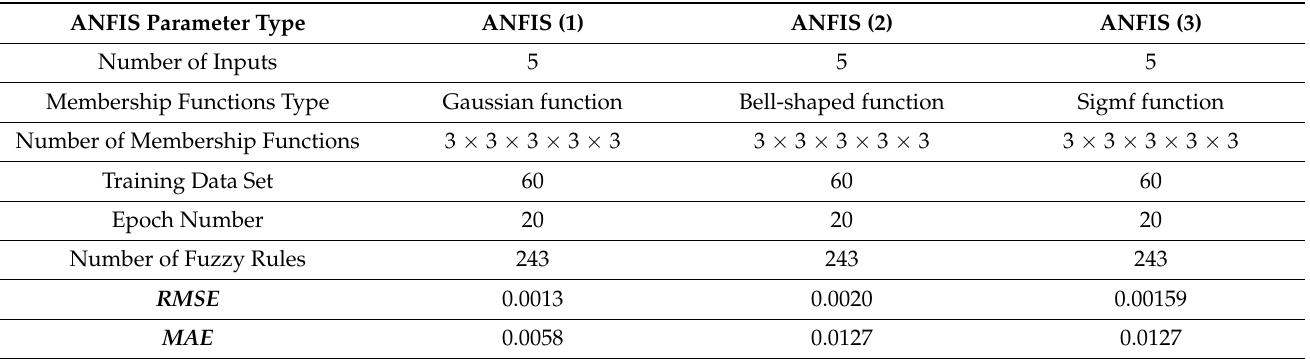
Table 7. Summary of the considered models for predicting the evaluation of partial indicators of